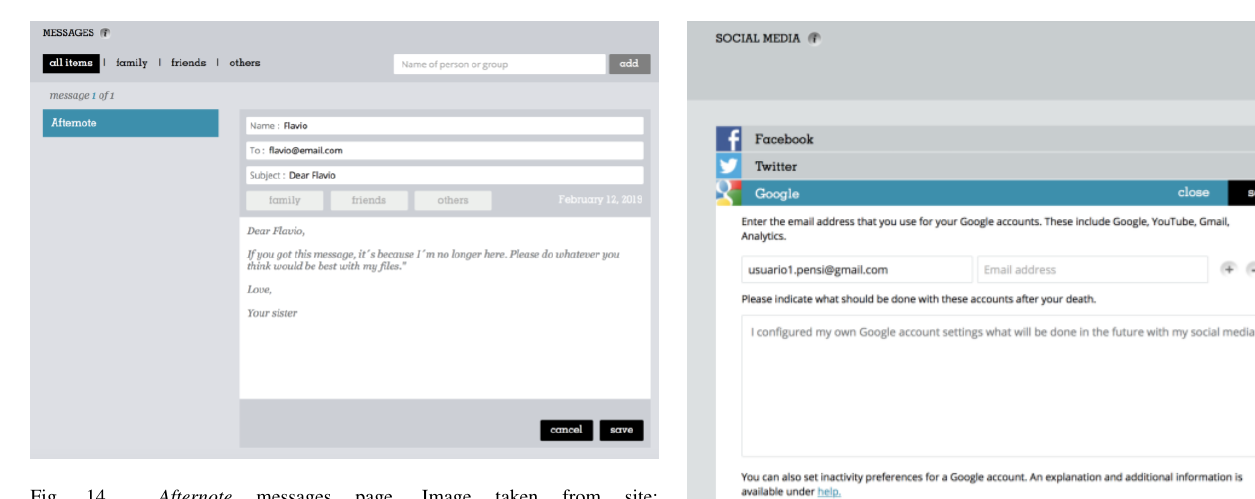
Afternote messages page. Image taken from site: https://www.afternote.com/messages.